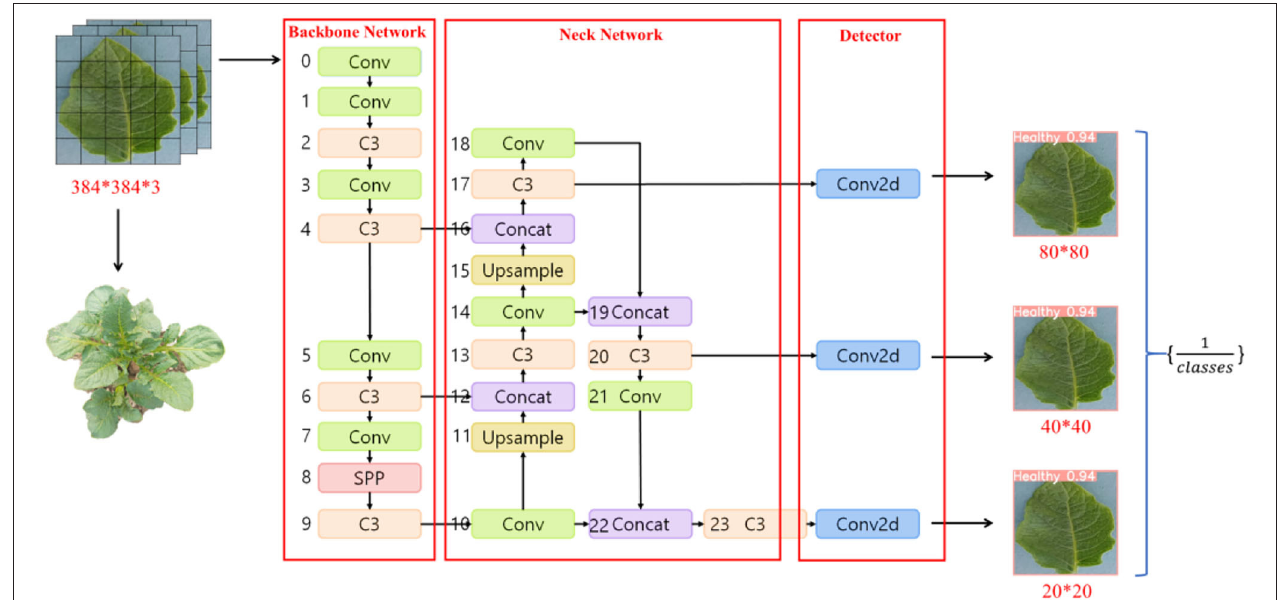
FIGURE 2 | Crop disease YOLOV5 network structure